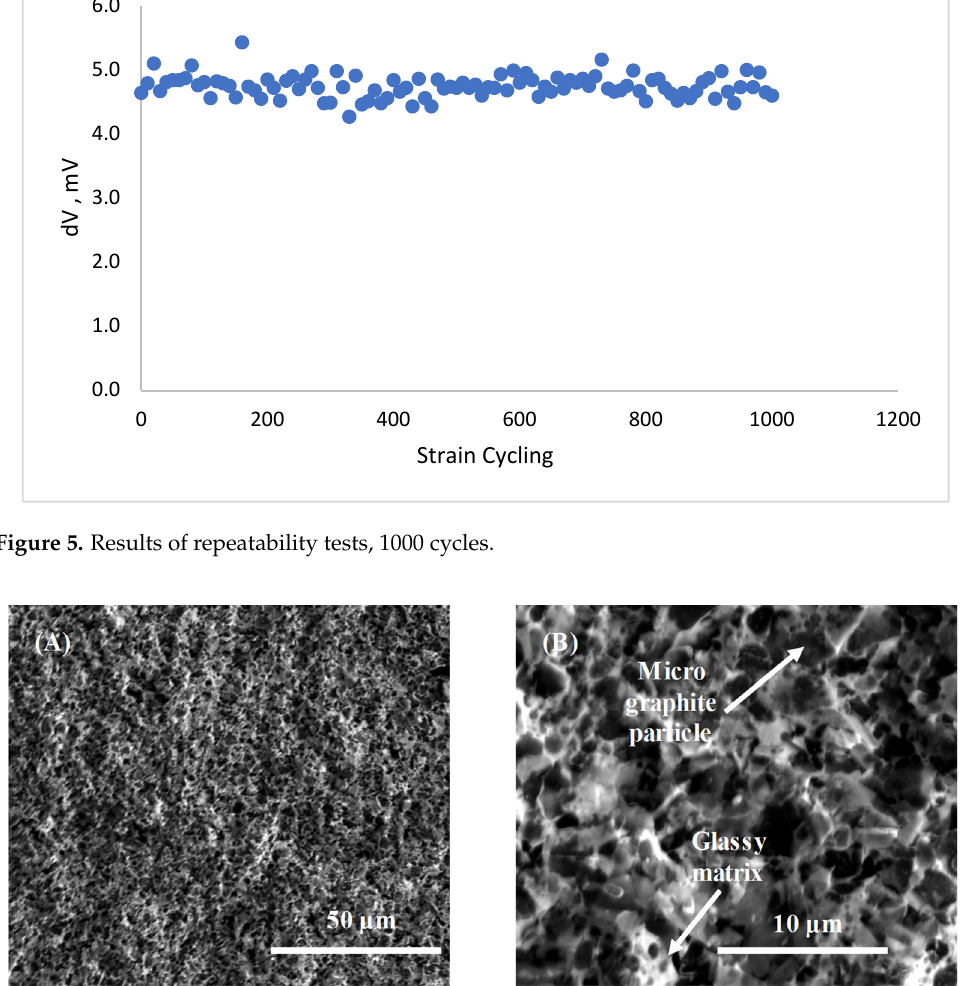
Figure 5. Results of repeatability tests, 1000 cycles.